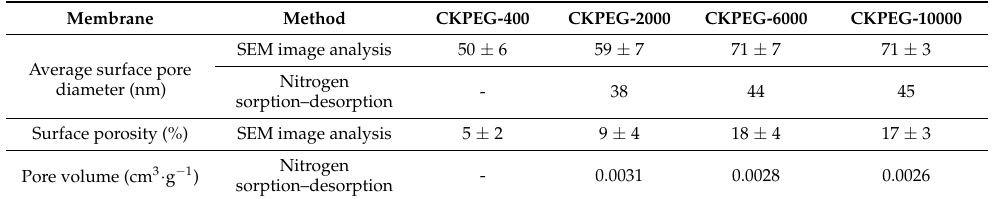
Figure 5. SEM surface images (magnification × 15,000) of a pure CS membrane (CS); a CS/KO composite membrane (CK) and CS/KO composite membranes with varying PEG Mw: 400 g · mol − 1 (CKPEG-400); 2000 g · mol − 1 (CKPEG-2000); 6000 g · mol − 1 (CKPEG-6000); 10,000 g · mol − 1 (CKPEG- 10000). Inset is a magnified view showing the porous structure of KO particles in the CK membrane. Magnification, × 50,000; scale bar, 600 nm. Table 2. Surface pore size and porosity for CK membranes prepared using PEG of varying Mw as pore